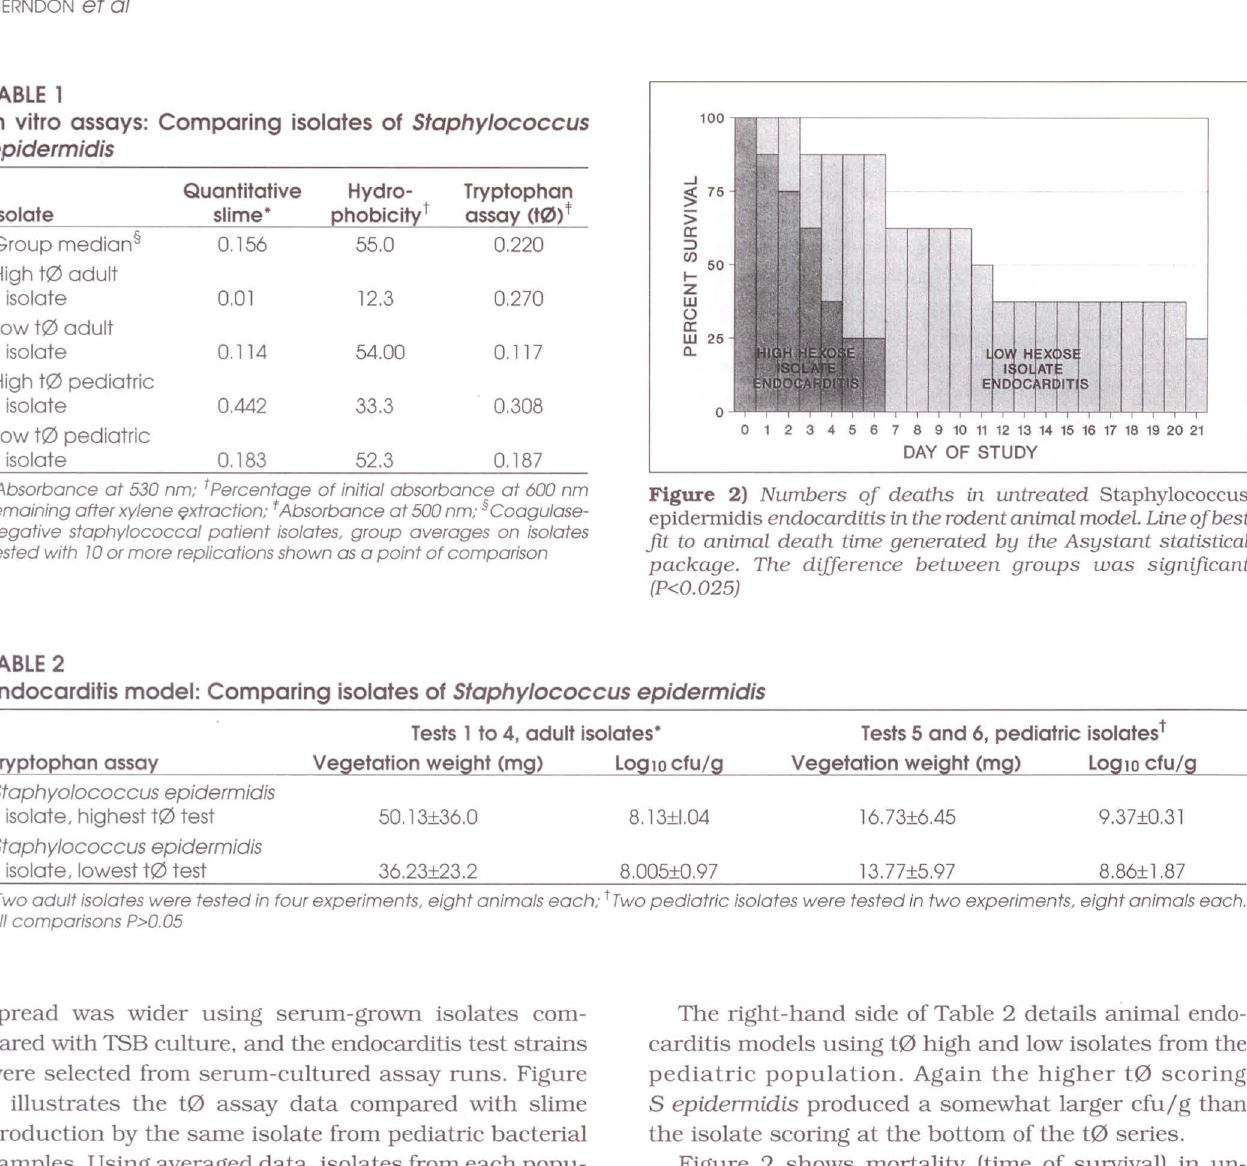
In vitro assays: Comparing isolates of Staphylococcus